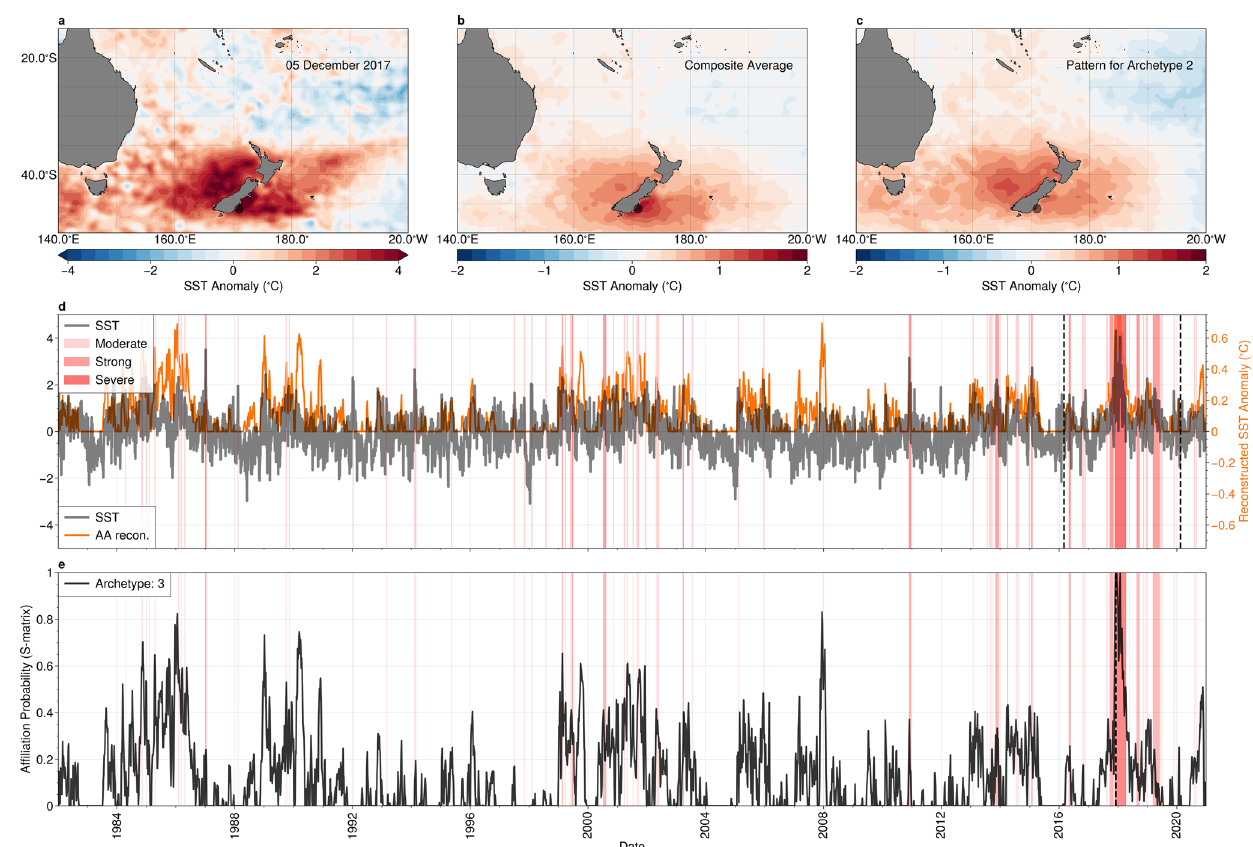
Fig. 5 | The relationship between marine heat waves and archetype #2 in the Tasman Sea. a Snapshot of sea-surface temperature (SST) anomalies for the peak of the 2017 – 2018 severe marine heatwave event, which occurred on the 5th of December,2017;and b SSTcompositeaverageforallmarine heatwavedetected at a representative location. Statistics are calculated at the representative location 45.9°S,171°E, indicated by the grey circle. c The SST anomalies for best matching